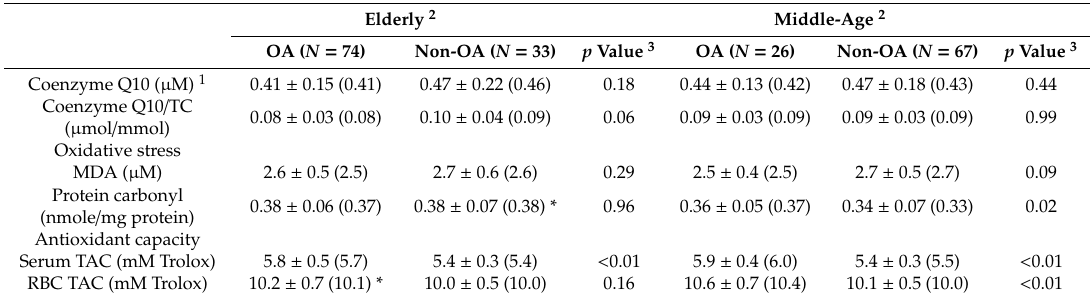
Table 1. Coenzyme Q10 status, oxidative stress, and antioxidant capacity of the